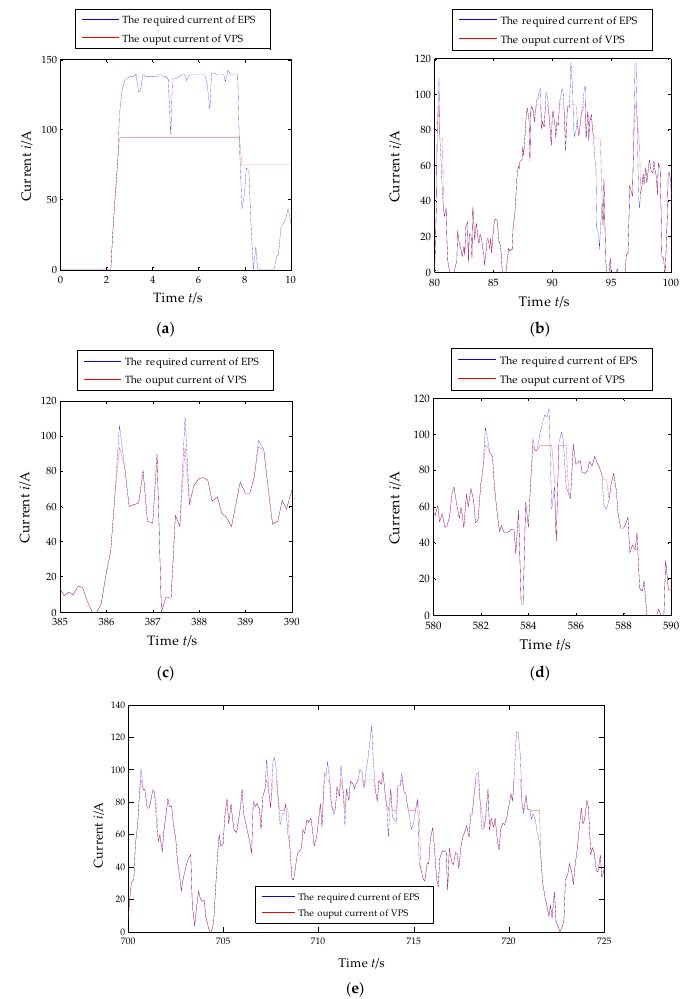
Figure 12. The detailed comparison results of the VPS output current between before and after optimization: ( a ) the comparison from 0 to 10 s; ( b ) the comparison from 80 to 100 s; ( c ) the comparison from 385 to 390 s; ( d ) the comparison from 580 to 590 s; ( e ) the comparison from 700 to 725 s. The charging and discharging current of the super capacitor are shown in Figure 13. Compared with Figure 11, it can be found that when the required current of EPS is higher than 93.6 A, the output current of the vehicle power supply is 93.6 A, and the lacking current is provided by the super capacitor, which acts the ‘peak clipping’ effect of SC; when the required current of EPS is lower than 74.7 A, the SOC of SC is checked to decide whether it needs to be charged. If necessary, the output current of the VPS is adjusted to 74.7 A, which not only meets the needs of the EPS, but also supplies power to the SC. In this way, the ‘valley filling’ effect of SC is exerted and the output current of the VPS is more stable. It can be seen from Figure 13 obviously, the charging current of SC is higher than the discharging current, which ensures that the SOC of SC keeps high and stable so that the SC has better current peak absorption especially when the required current of EPS is high. The SOC trend of SC is shown in Figure 14. The comparison results show that the proposed rule-based energy management strategy can meet the current requirements of EPS in the heavy-duty vehicles, and significantly reduce the output current peak of the VPS from more than 140 A to 93.6 A and effectively depress the output current fluctuation of the VPS.